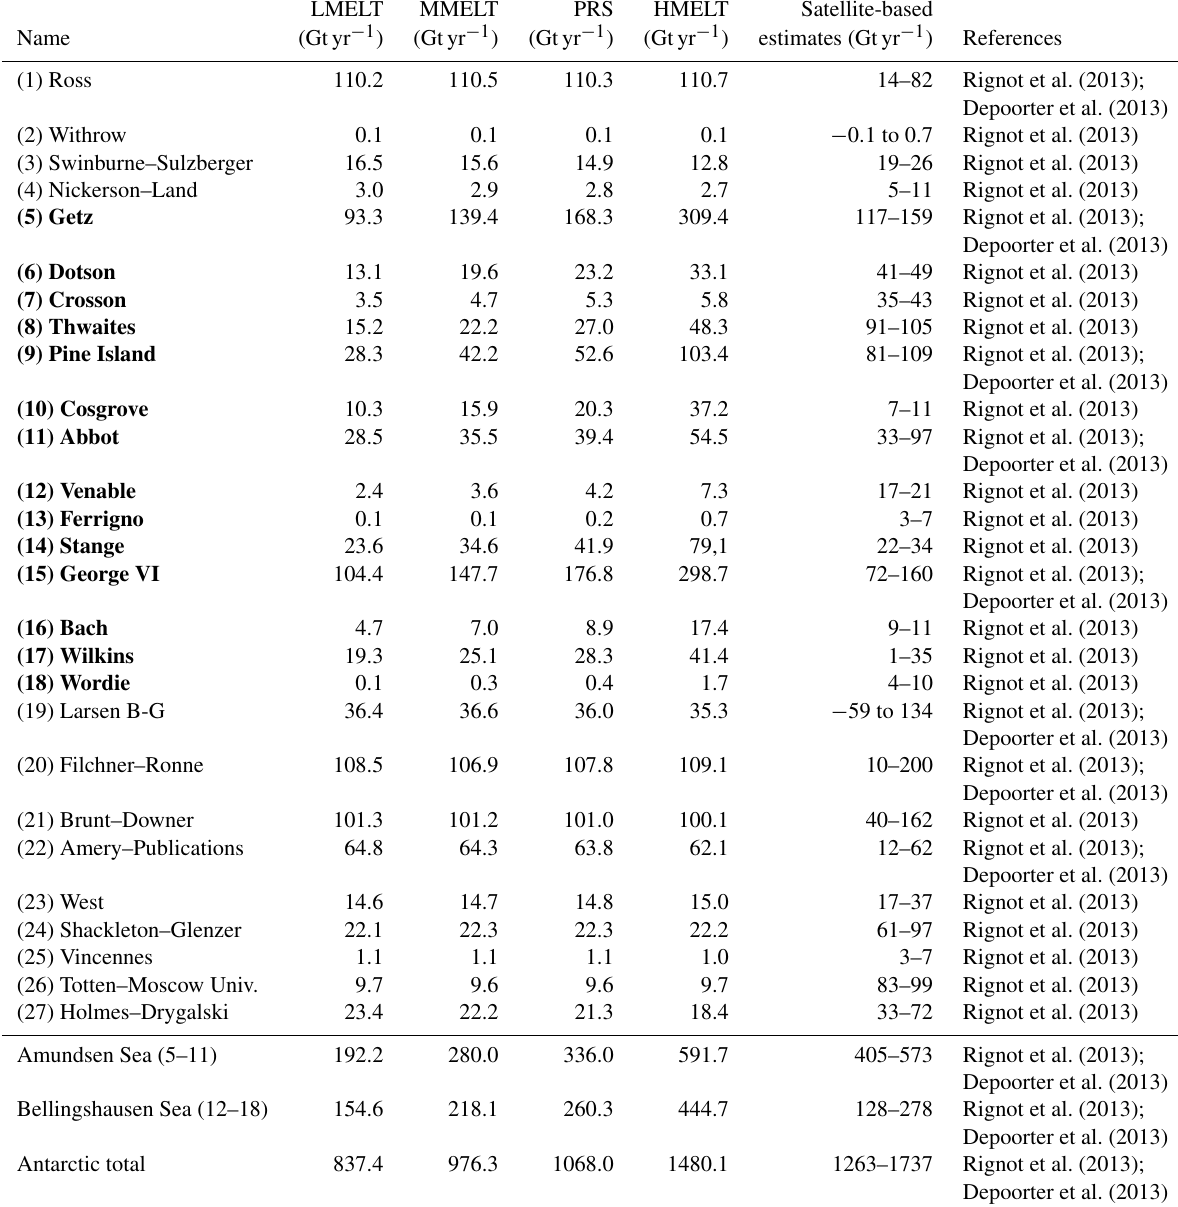
Table 2. Antarctic ice shelf basal mass loss from LMELT, MMELT, PRS, HMELT, and satellite-based estimates (Depoorter et al., 2013; Rignot et al., 2013). Ice shelf locations are indicated by numbers in Fig. 1. For some ice shelf regions in the Weddell Sea and East Antarctica (19–22 and 24–27, respectively), basal melt rates are accumulated for several ice shelves and compared to the satellite-based estimates as indicated in Fig. 1. Turbulent heat and salt exchange coefficients for ice shelves in AS and BS (bold) are increased in sensitivity